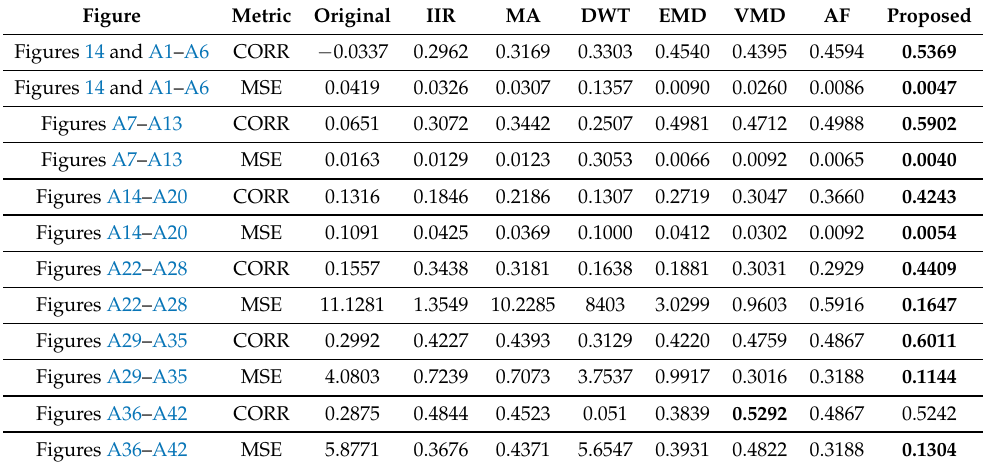
Table 2. Comparison between different noise removal